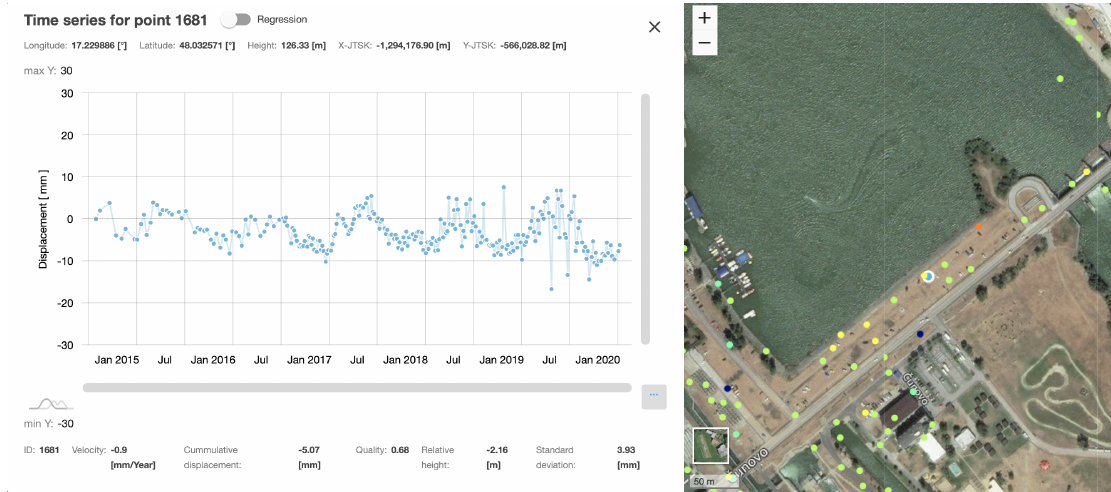
Figure 17. Time-series shown for low-coherent point (0.68) preserved in final results over Cunovo dam with seasonal effect recorded for the problematic part of the dam.